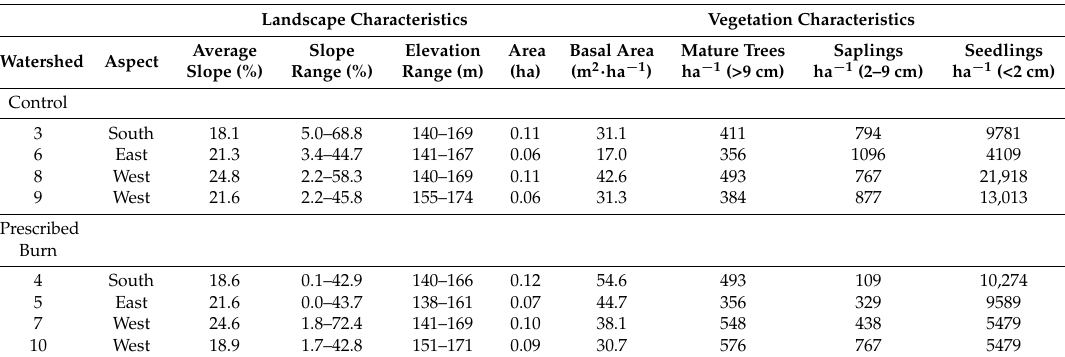
Table 1. Watershed characteristics including landscape features and vegetation densities at Trail of Tears State Forest, IL. Landscape